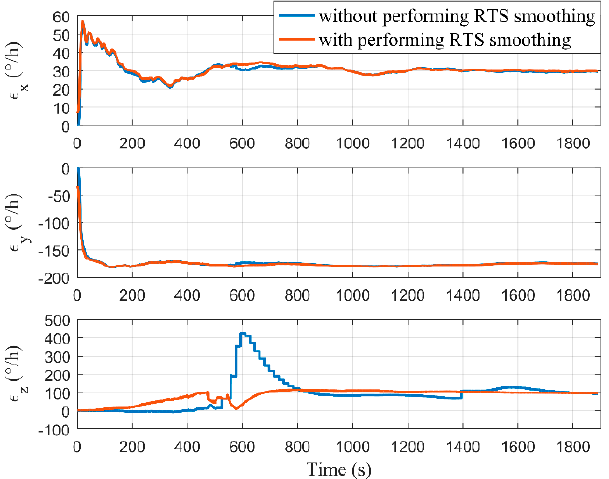
Figure 10. Estimation results of the gyro biases with and without performing RTS smoothing.